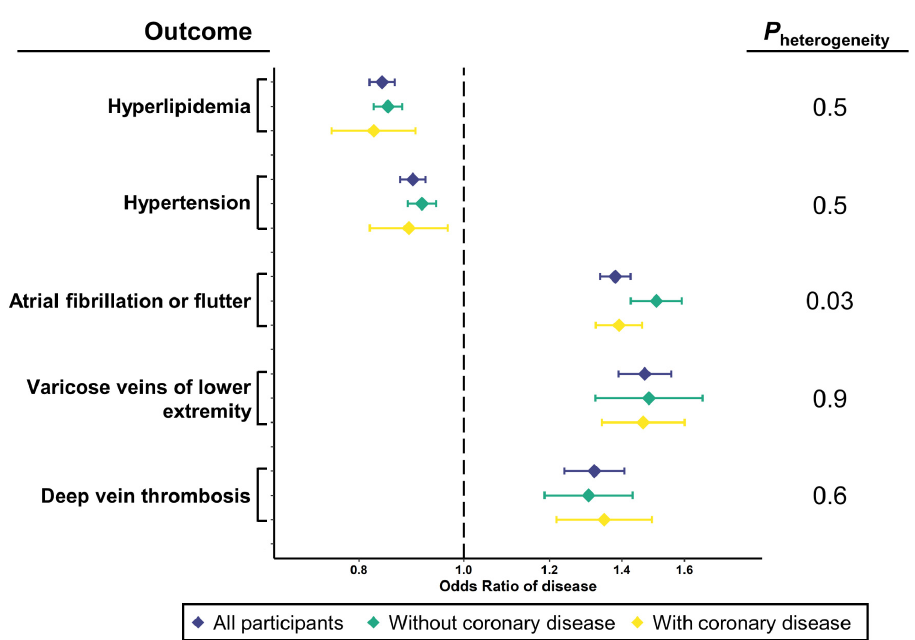
Fig 4. Associations of selected traits with genetically-predicted height after stratifying by coronary heart disease status. Odds ratio (OR) and 95% confidence intervals shown for associations of the indicated traits with genetically- predicted height in all participants (purple), those without coronary heart disease (green) and those with coronary heart disease (yellow). P-values from test of heterogeneity between strata shown to the right.